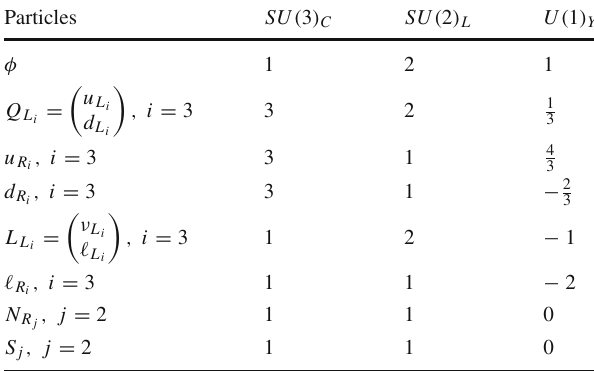
Table 1 SU ( 3 ) C , SU ( 2 ) L , U ( 1 ) Y quantum number assigned to the particles. i denotes the number of fermionic generations Particles SU ( 3 )